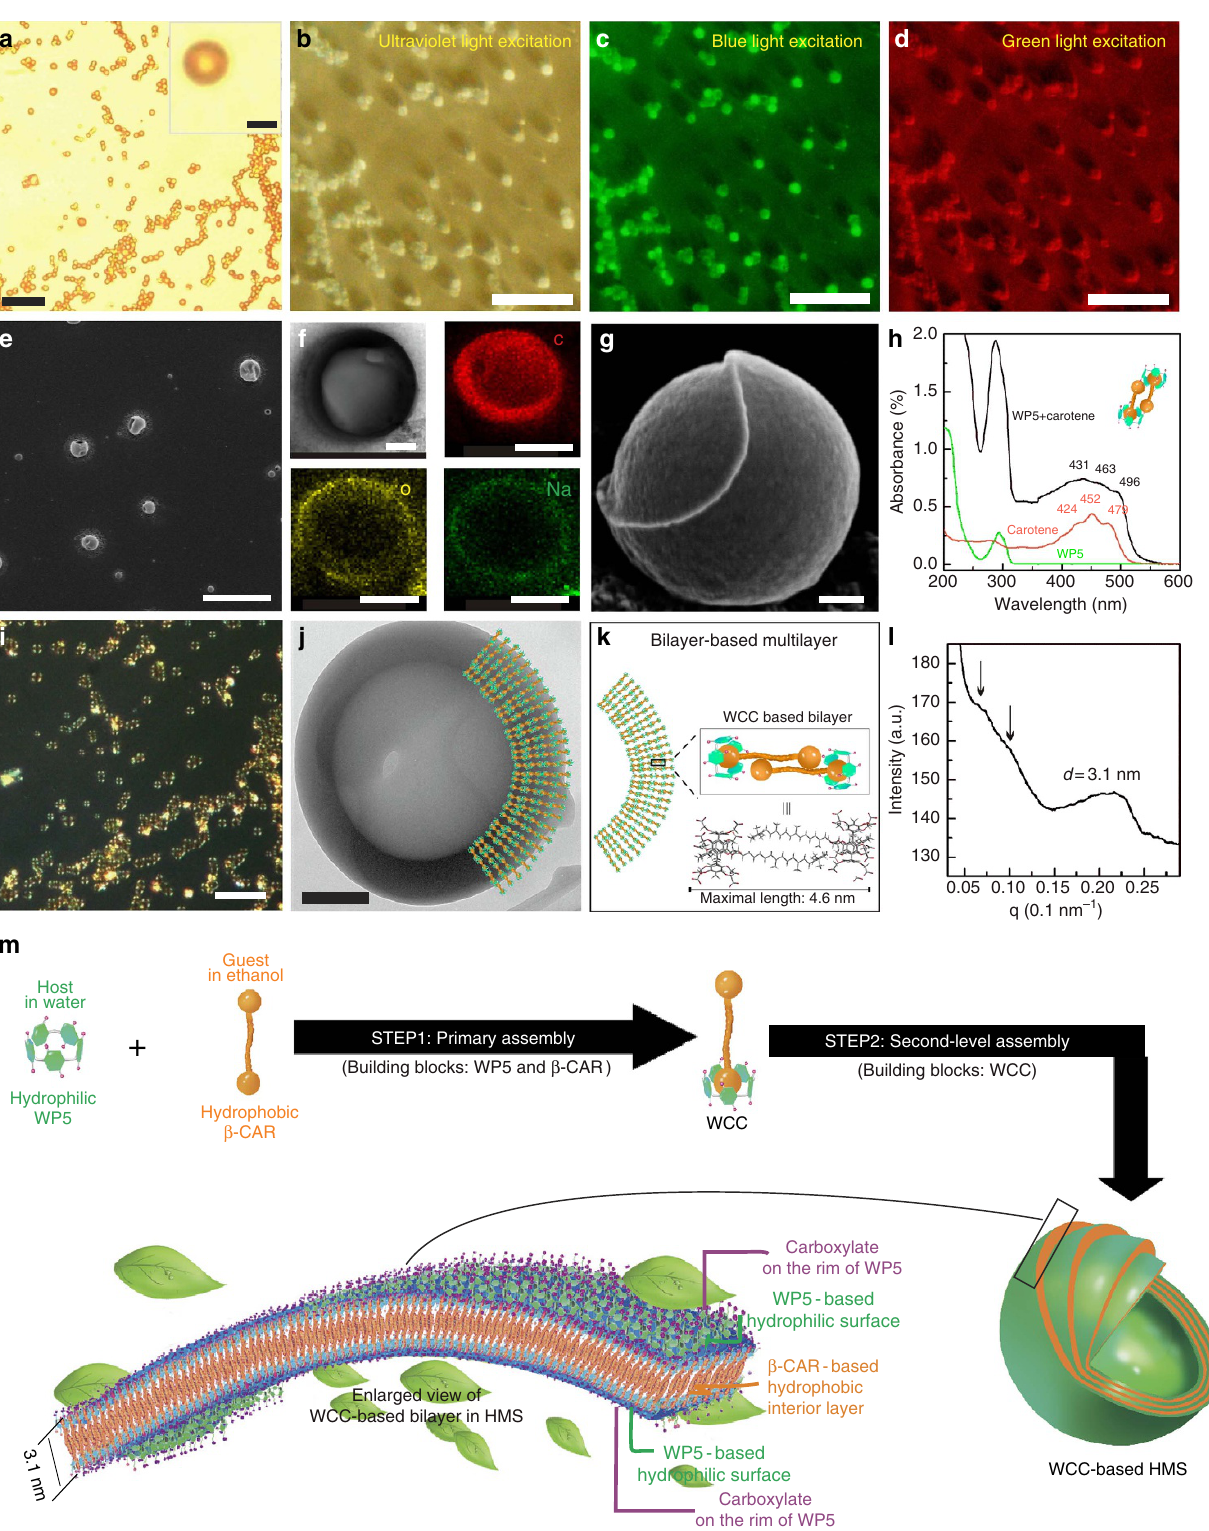
Figure 3 | Synthesis of WCC-based HMS. ( a ) OM image of HMSs over a large area. Scale bar, 10 m m (inset: enlarged image of an HMS; Scale bar, 1 m m). Large-area fluorescence microscopy images of HMSs under ( b ) Ultraviolet-light excitation, ( c ) blue-light excitation and ( d ) green-light excitation. ( e ) SEM image of HMSs. Scale bar, 10 m m. ( f ) Top left, TEM image of an enlarged WCC-based HMS; Scale bar, 500nm. EDX mapping images of a WCC-based HMS: top right, distribution of element C; lower left, distribution of element O; lower right, distribution of element Na. Scale bar, 1 m m. ( g ) SEM image of an HMS with a broken shell. Scale bar, 200nm. ( h ) ultraviolet–visible spectra of HMSs, b -CAR and WP5. ( i ) Polarized image of HMSs (the colour in this image is false). Scale bar, 10 m m. ( j ) TEM image of an HMS. Scale bar, 200nm. ( k ) Cartoon of WCC-based multilayers in the HMSs. ( l ) SAXS profile of the HMS sample (the final concentration of both HMS and b -CAR is 75 m M) with an acquisition time of 5h. ( m ) Schematic of the HMS formation